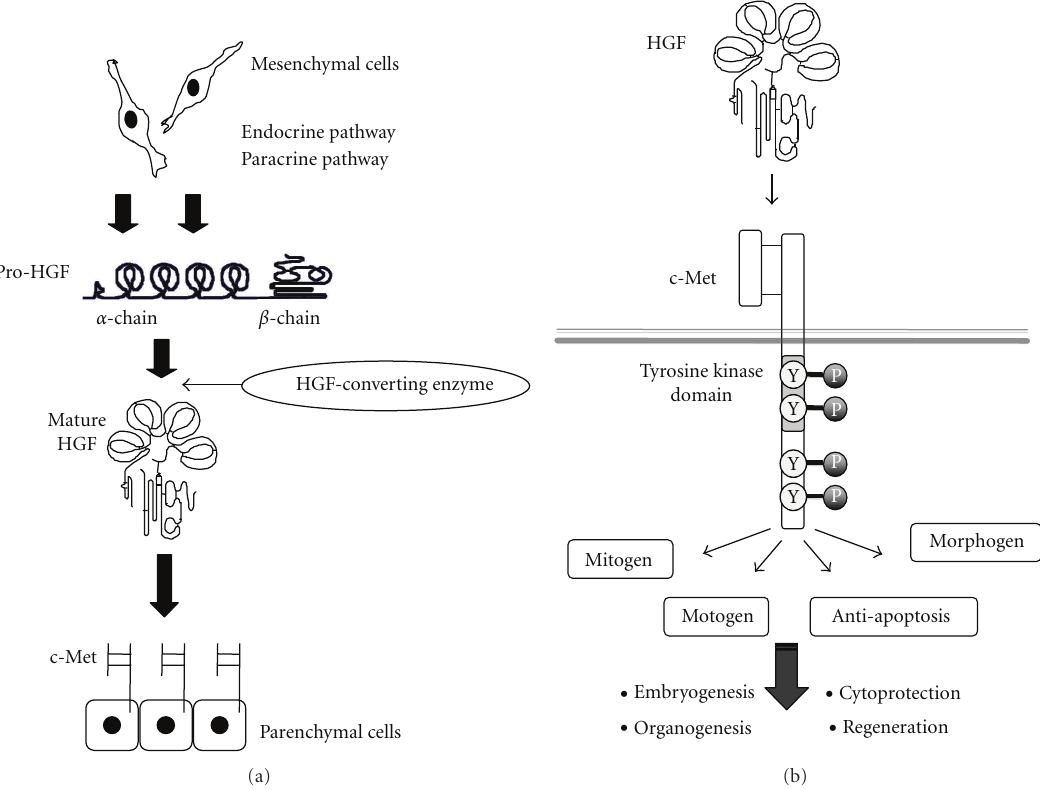
Figure 1: Production and multifaceted functions of HGF. (a) Production, activation, and delivery of HGF. HGF is produced in mesenchymal cells such as fibroblasts. HGF is secreted in an inactive form (i.e., pro-HGF). Under injurious conditions, pro-HGF is converted to mature HGF by HGF-converting enzymes, such as uPA. HGF is delivered to injured sites via endocrine and paracrine pathways [10]. (b) Multifaceted biological actions of HGF, mediated via c-Met tyrosine phosphorylation, are outlined. Induction of mitogenic, motogenic, and morphogenic (3M) e ff ects of HGF are essential for organ development and regeneration. Anti-apoptotic e ff ects are required for protection against various types of organ